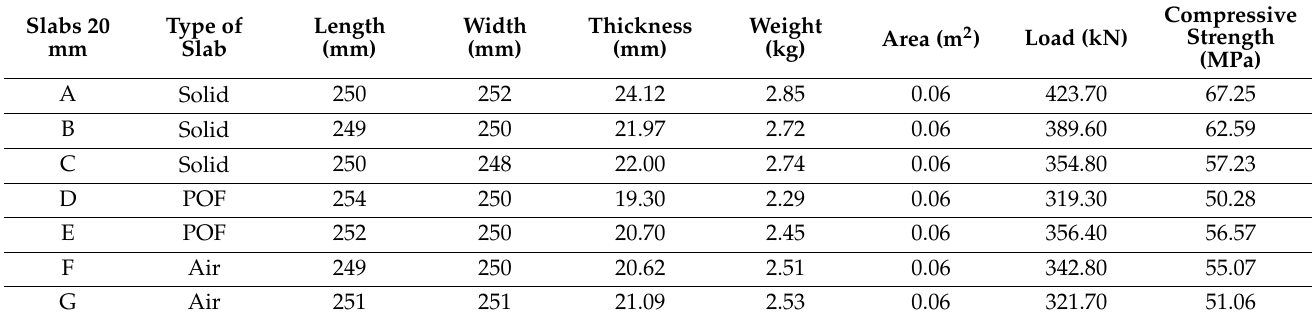
Table 11. Properties of slabs 20 mm thick for measuring compressive strength.